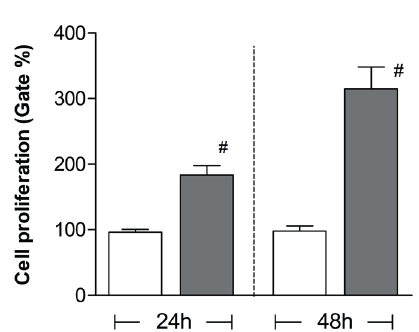
Figure 4 - Mice splenocytes proliferation index evaluated using CFSe staining. Saline extract from M. emarginata leaves promoted proliferation in mice splenocytes in both times evaluated (24 and 48 hours of assay). Vertical white bars represent negative control cells (cells + culture medium) and vertical gray bars represent saline extract from M. emarginata leaves at 12.5 µg/ml concentration. This assay was performed using three independent experiments performed in duplicate. #P=